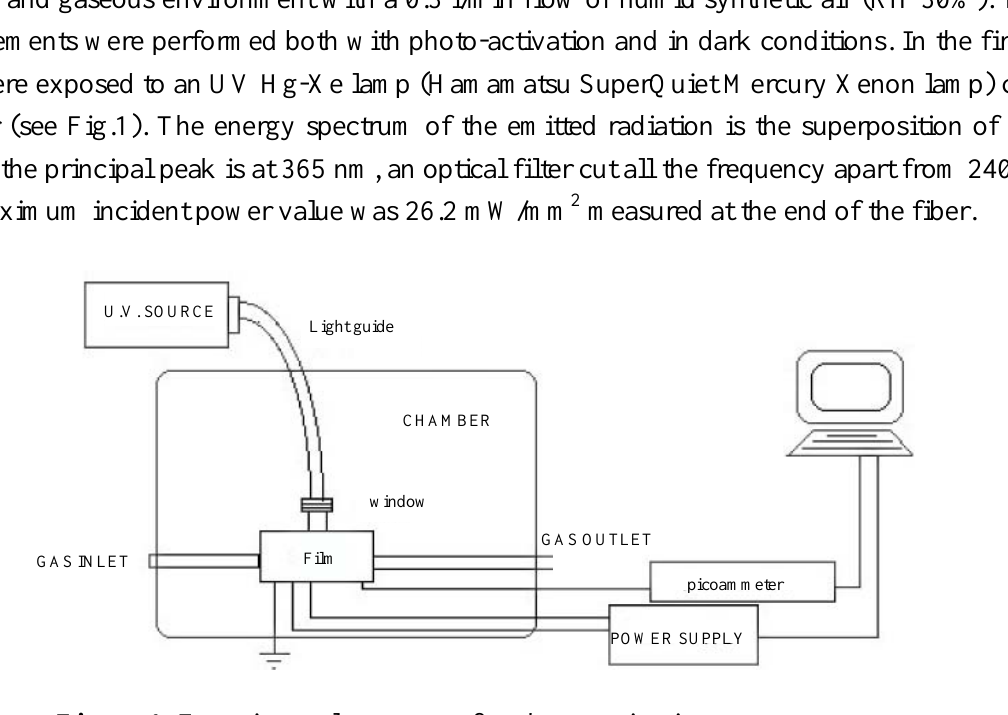
Figure 1. Experimental apparatus for photo-activation